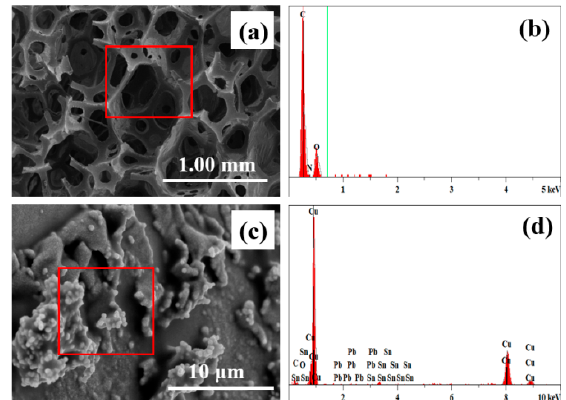
Figure 4. ( a ) The SEM and ( b ) energy spectrum of the sample before copper plating; ( c ) the SEM and ( d ) energy spectrum of the sample after copper plating.